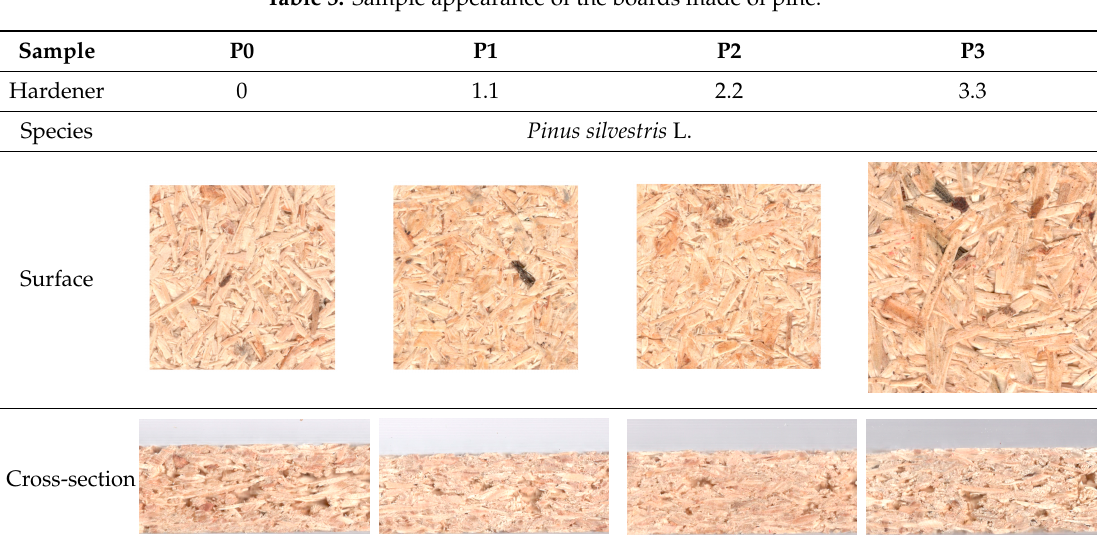
Table 4. Sample appearance of the boards made of oak. Sample